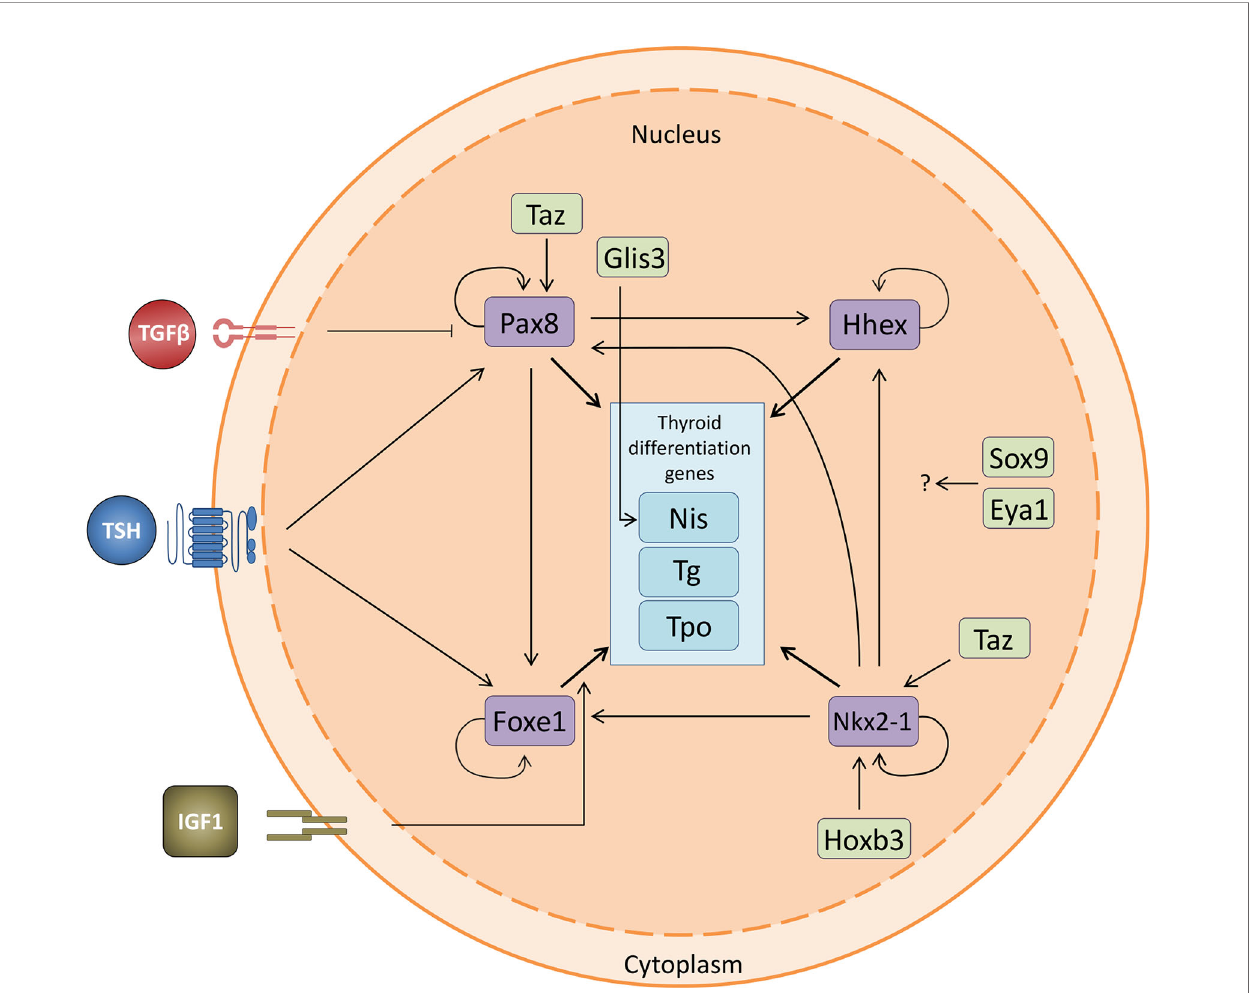
FIGURE 4 | Thyroid transcription factor crosstalk. Relationship between the four thyroid transcription factors and the thyroid differentiation genes, including the interaction with the novel transcription factors involved in thyroid differentiation. Nkx2-1 is regulated by Taz and Hoxb3 and promotes the expression of the other three TTFs. Pax8 regulates the expression of Hhex and Foxe1 and is positively regulated both by TSH and Taz. It is also negatively regulated by TGF b . Foxe1 is positively regulated by TSH and IGF1. All four TTFs promote the expression of the thyroid differentiation genes Nis (Slc5a5 ), Tg and Tpo . The effect of Sox9 and Eya1 remains to be fully elucidated. Pointed arrows denote activation while fl at arrows indicate